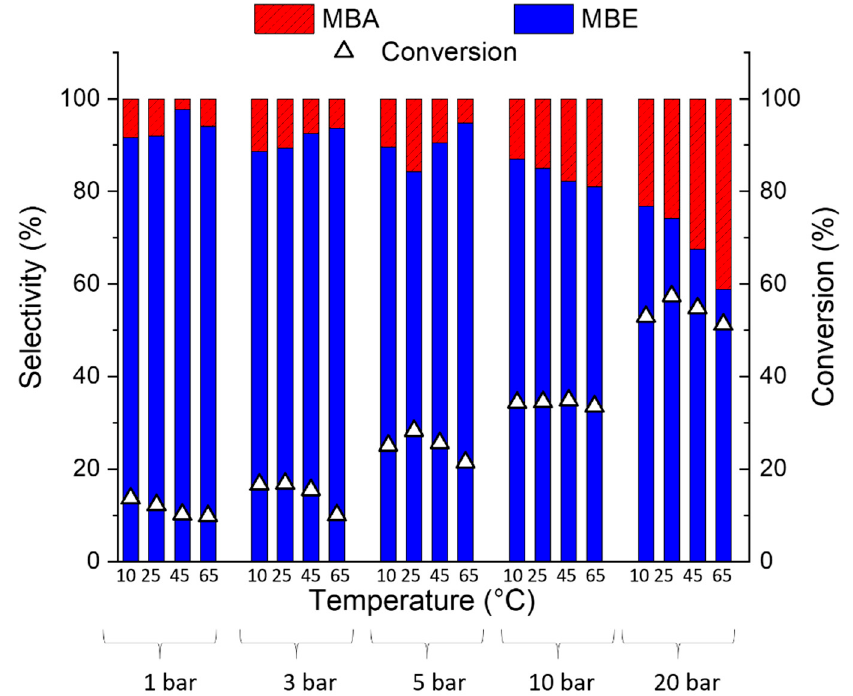
Figure 11. The effect of reaction conditions on the conversion and selectivity of red(600 ◦ C)-Pd/ γ - Al 2 O 3 to 2-methyl-3-buten-2-ol and 2-methyl-2-butanol in 2-metyl-3-butyn-2-ol hydrogenation with 0.5 mL/min flow rate of the reactant and 6 mL/min of the H 2 flow.